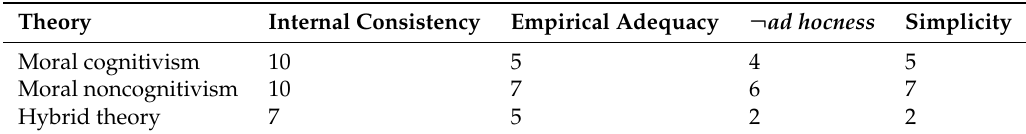
Table 3. Theory choice in philosophy.